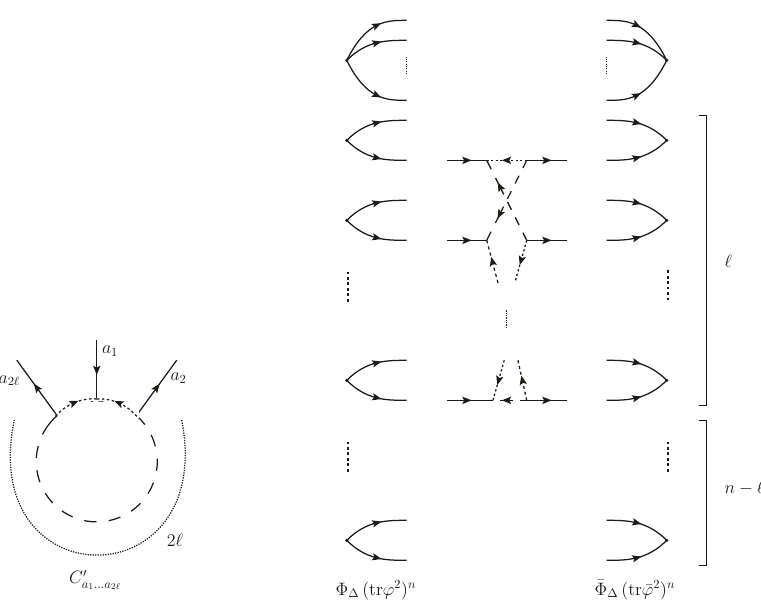
Figure 2 . Generic 2 ‘ -legs diagram with its color factor in the di(cid:11)erence theory. The straight lines represent ’; (cid:22) ’ (cid:12)elds, the dashed line generically represents the hypermultiplet loop. On the right we see how to insert it in the maximal non planar way, which gives the leading order in the double scaling